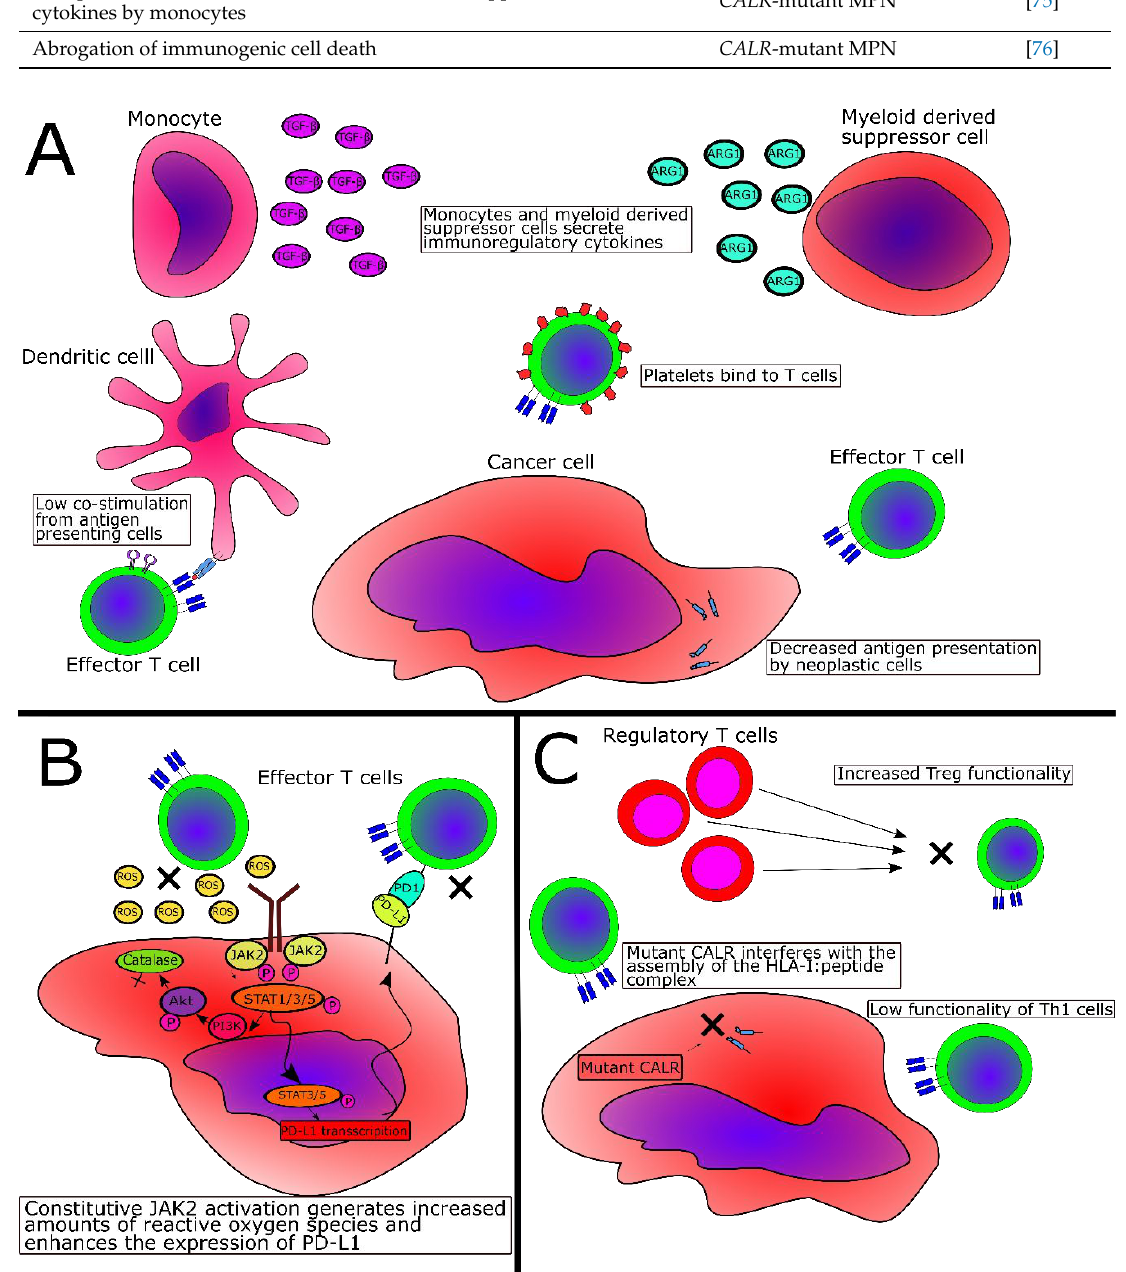
Figure 1. Suggested immune escape mechanisms in MPN. ( A ). Escape mechanisms that are shared between all MPN types, starting from the top and moving clockwise. Myeloid cells such as monocytes and myeloid-derived suppressor cells secrete TGF-β and ARG1, respectively. These proteins are highly immunosuppressive to T cells and thus induce immune suppression in the tumor microenvironment (TME). Platelets, which suppresses T cell reactivity, are released from the hyperproliferating megakaryocytes and bind to T cells, thereby suppressing tumor-specific T cells. Both JAK2 - and CALR -mutant cells express lower levels of HLA-I molecules, resulting in decreased antigen presentation to T cells, thus facilitating tumor immune escape. Antigen-presenting cells express lower levels of costimulatory molecules, thus decreasing the priming of T cells. ( B ). Escape mechanisms that are employed, especially in JAK2 -mutant MPN. The JAK2 V617F mutation induces the activation of STAT1/3/5, whichh increases the activity of PI3K and Akt, thereby lowering the levels of the ROS-converting enzyme catalase. This results in increased levels of ROS in the TME, which decreases T cell reactivity. The JAK2 V617F mutation induces the activation of STAT3/5, which enhances the transcripition of PD-L1, which is expressed on tumor cells, resulting in the